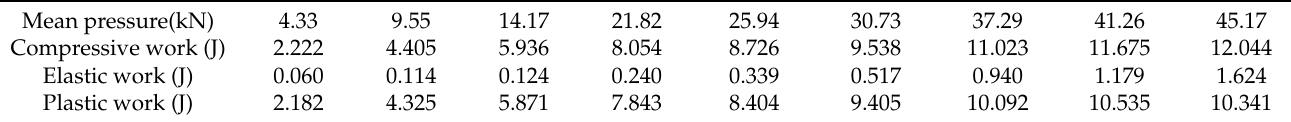
Figure 6. ( A ) The force-displacement curve of the mixed powder under compression pressure of 12 kN. ( B ) Detail in enlarged scale (2.25–2.65 mm). Table 4. The energy of the different compression pressures.